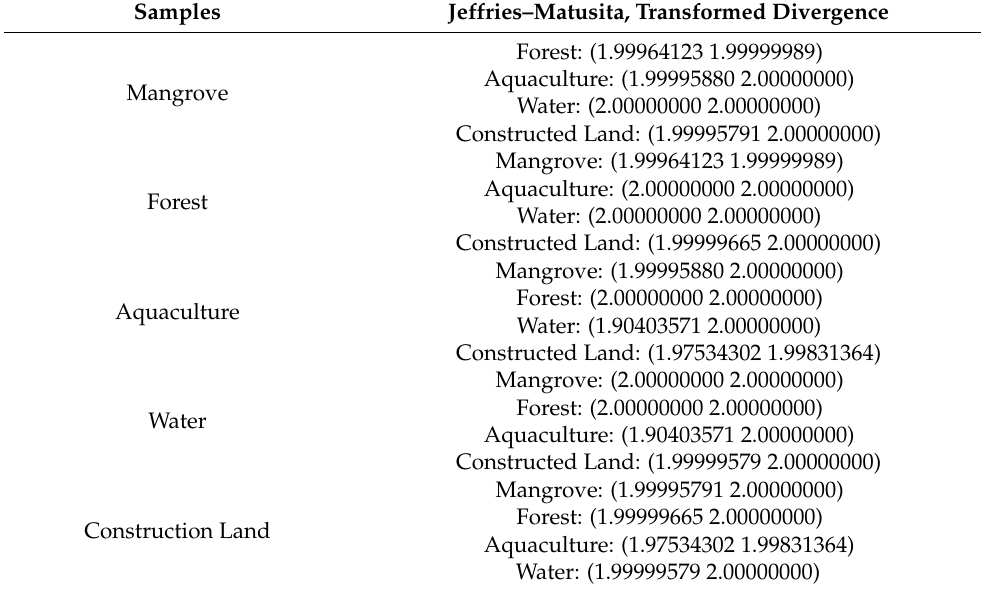
Table 3. Severability of samples in